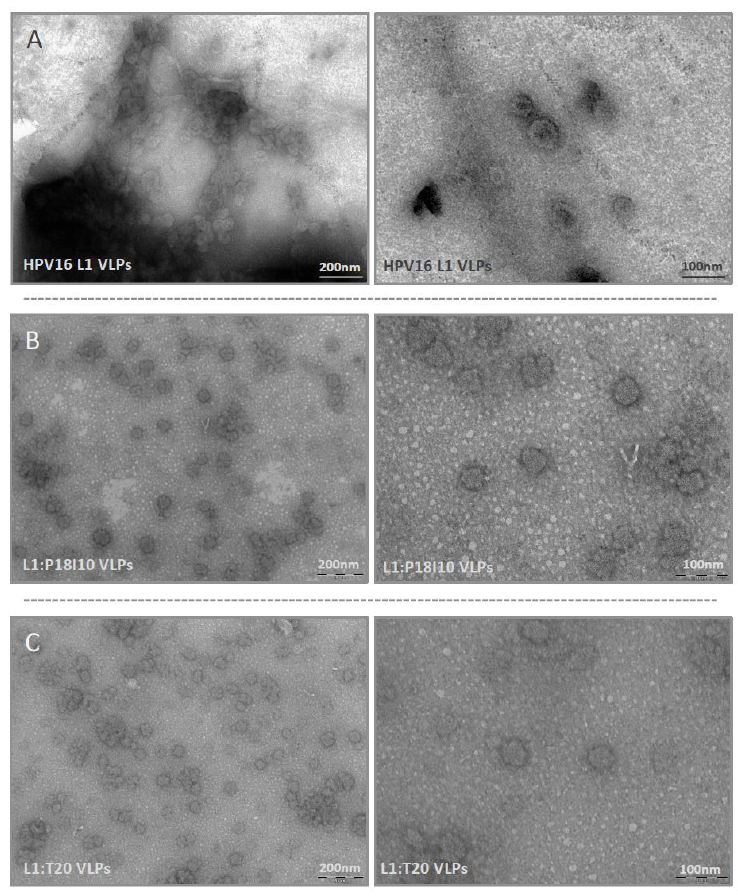
Figure 4. Electron micrographs of L1:P18I10 and L1:T20 VLPs. ( A ) Morphology of HPV16 VLPs. ( B ) Morphology of L1:P18I10 VLPs. ( C ) Morphology of L1:T20 VLPs. Purified VLPs were absorbed on UV-charged carbon-coated copper grids, and negatively stained with 2% uranyl acetate. Images were acquired under transmission electron microscopy. The bar represents 200 nm at magnification 59,000 (left panel) and 100 nm at magnification 135K (right panels), respectively. 3.5. Presentation and Reactivity of the HPV-16 and HIV-1 Epitopes To confirm that sequential HIV-1 P18I10 or 2F5 epitopes were presented in chro- matography-purified L1:P18I10 or L1:T20 VLPs, Western blot analysis and indirect